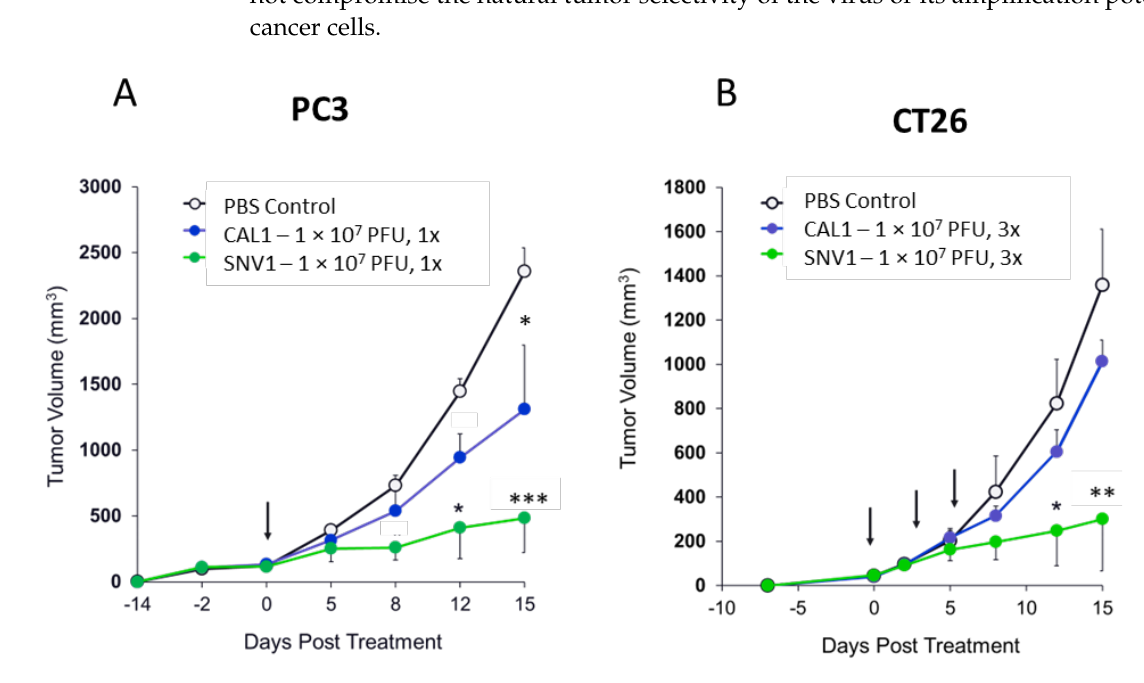
Figure 3. Inhibition of tumor growth after treatment with SNV1 or with CAL1 naked vaccinia virus. ( A ) Athymic nude male mice aged 4–6 weeks were inoculated s.c. with aggressive metastatic prostate cells (PC3) in the right flank. When tumors reached about 200 mm 3 animals were i.t treated (day 0, arrow) with a single dose of 1 × 10 7 PFU of CAL1 vaccinia virus or 1 × 10 6 SNV1 cells (10 PFU/cells) (n = 10). ( B ) Female BALB/c mice were inoculated s.c. with 2.5 × 10 5 murine colon cancer cells (CT26). When tumor sizes were around 50 mm 3 , mice were i.t treated with 1 × 10 7 PFU of CAL1 vaccinia virus or 1 × 10 6 SNV1 cells three times (arrows), every 3 days (n = 6–7) (day 0, marks as the first treatment). Data is presented as geometric mean with SEM. PBS treated group served as a control.